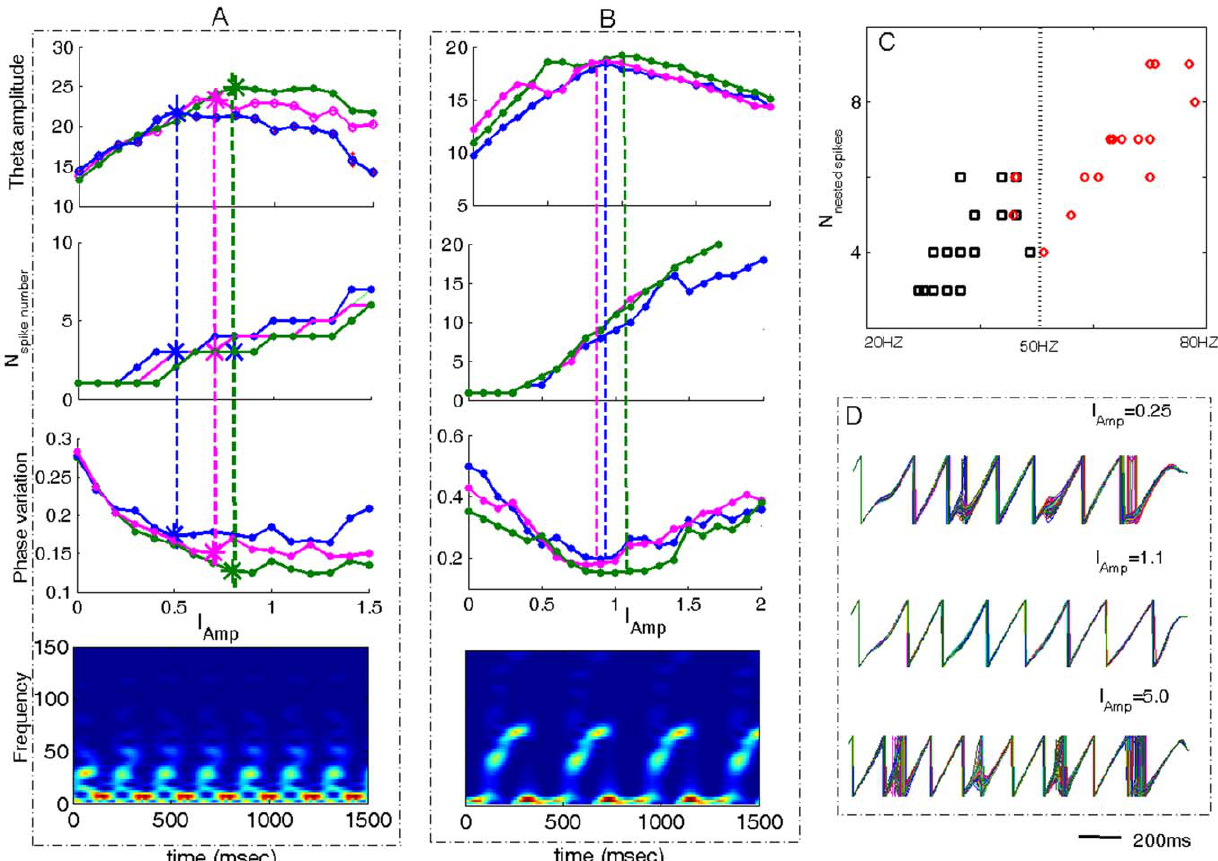
Figure 6. Relationship of maximal theta amplitude, the number of nested spikes per theta cycle and theta-phase concentration. (A- B) From the upper trace to the bottom trace:Theta amplitudes vs. the stimulus strength I Amp , the corresponding number of nested spikes per theta cycle of one curve. In (A), a GABA , fast ~ 1, t GA : fast ~ 9, a GABA , slow ~ 0 : 2, t GABA , slow ~ 50, vs. I Amp , theta phase variation vs. I Amp , and the time-frequency spectra at I c Amp the three curves correspond to g GAse ~ 0 : 05,0 : 06,0 : 07 . In (B), a GABA , fast ~ 0 : 5, t GA : fast ~ 4 : 5, a GABA , slow ~ 0 : 2, t GABA , slow ~ 80 , the three curves correspond to I INs ~ 0 : 45,0 : 55,0 : 6 . (C) The number of nested spikes per theta cycle calculated at I c vs. the frequency of the corresponding maximal gamma power. The Amp . Onecan see that for low gamma power (20–50 Hz), around5 6 2 spikes could marked points are obtained fromdifferent curves of theta amplitude vs. I c Amp be nested in each theta cycle, while for high gamma power ( . 50 Hz), around 7 6 2 spikes could be nested. (D) Theta phases of the EX cells for different stimulus strength. It was shown that for too weak and too strong stimulus, the theta phases of neurons are less synchronized than that of the intermediate stimulus strength.